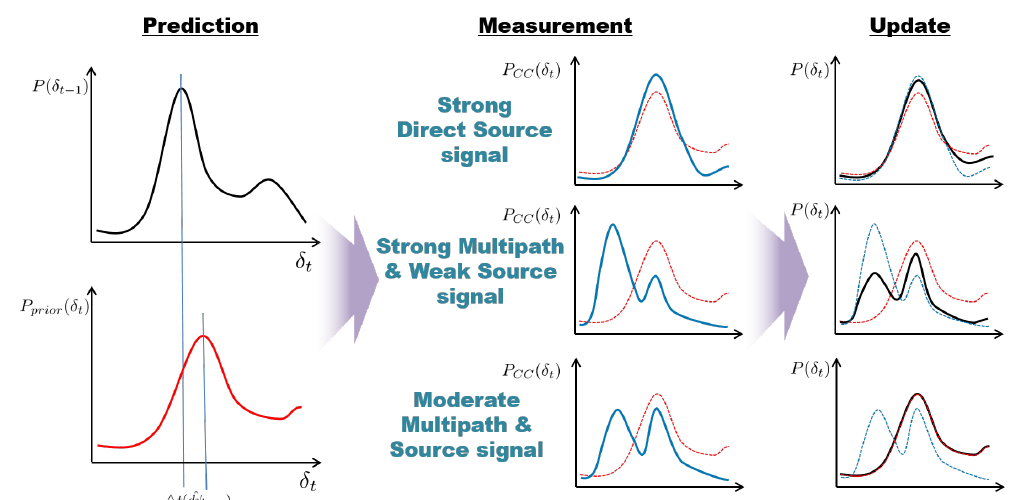
Figure 3. Illustration of time delay probability calculation. The black and red lines in the prediction step represent the probability at time step t − 1 and the predicted prior probability calculated by the angular displacement of the marine vehicle at time step t , respectively. In the measurement and update steps, the red lines represent prior probability, the blue lines represent the cross-correlation function, and the black lines represent the calculated time delay probability at time step t